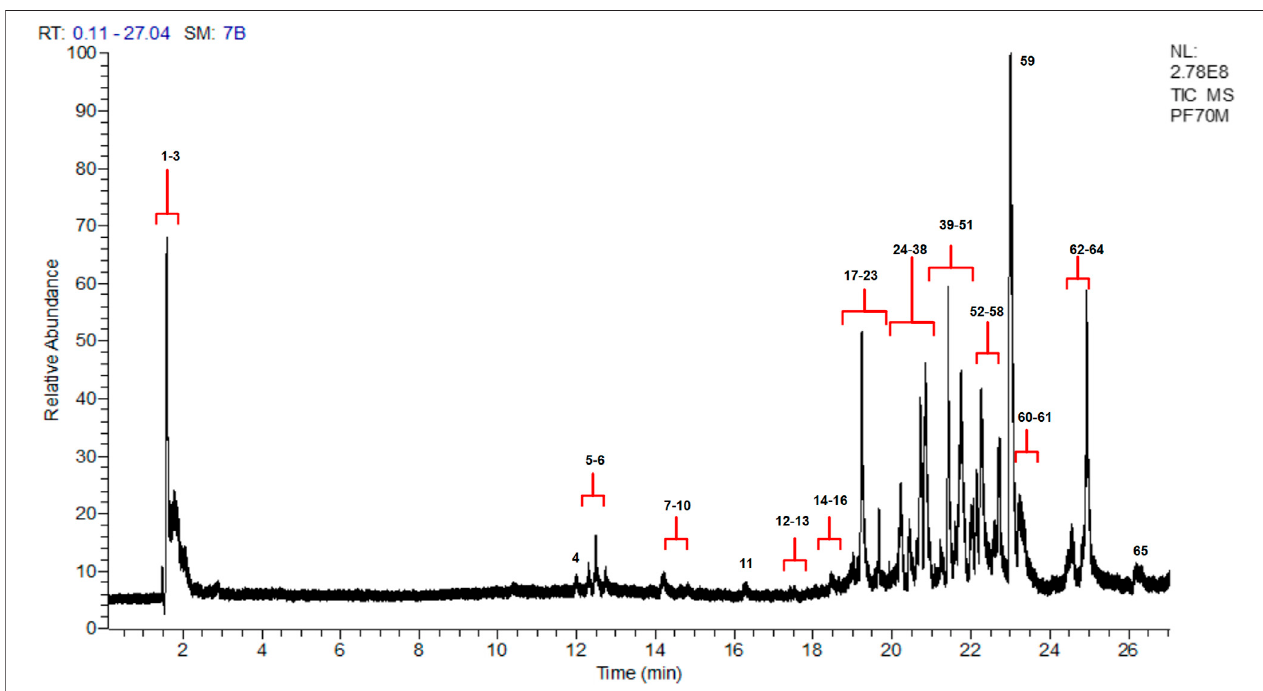
FIGURE 6 | UHPLC chromatograms of Pseudevernia furfuracea 70% methanol extract.